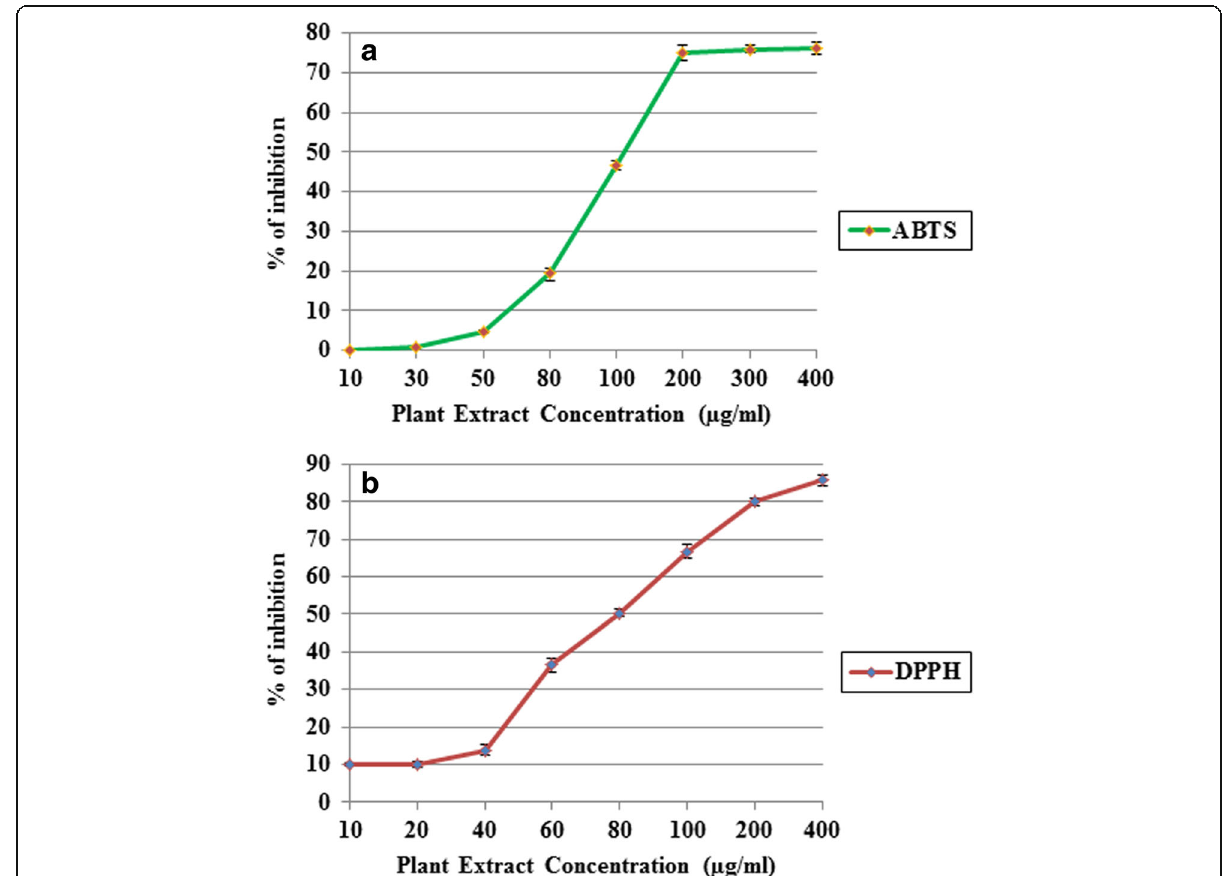
Fig. 2 Antioxidant potential of leaves extract of B. pilosa . a ABTS assay ( b ) DPPH assay